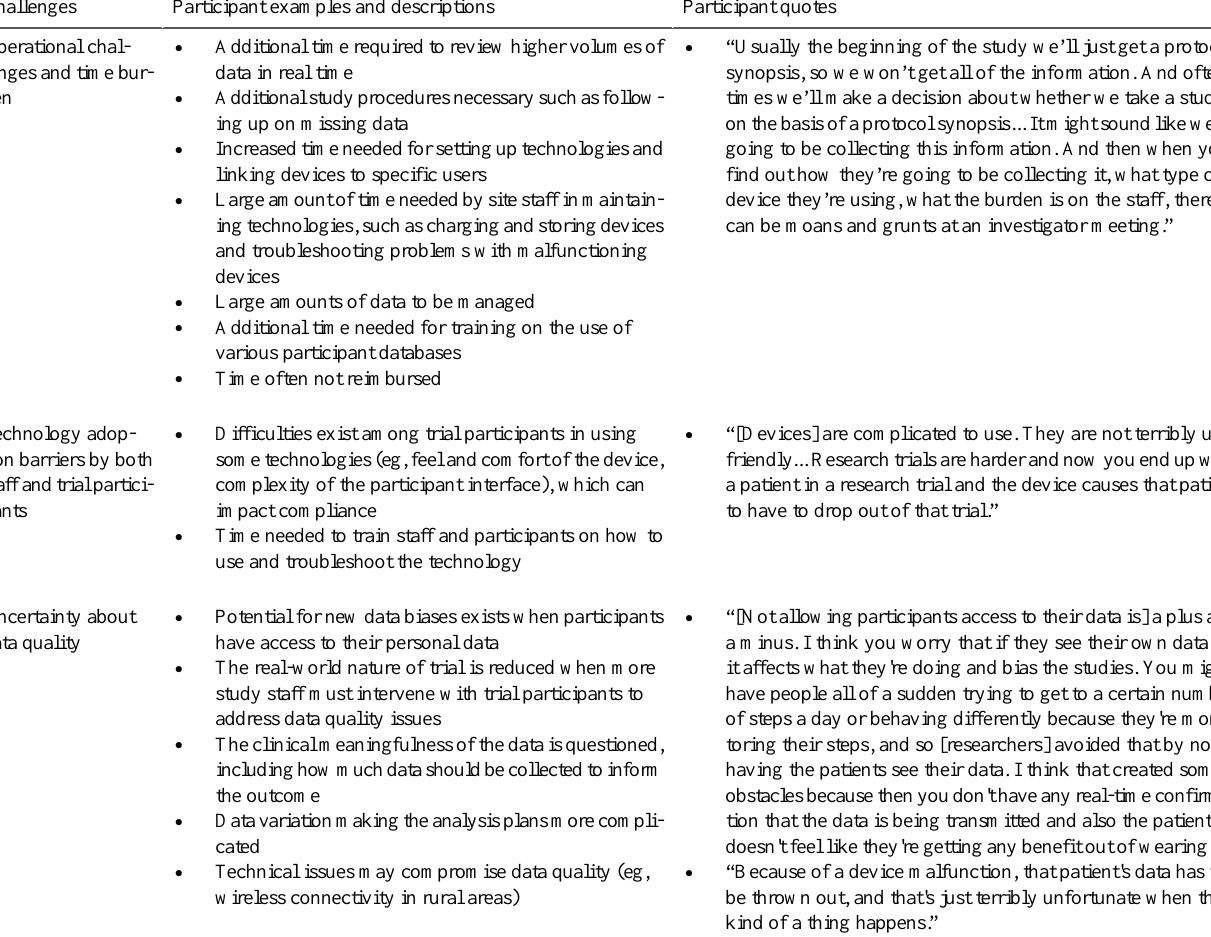
Participant quotesParticipant examples and